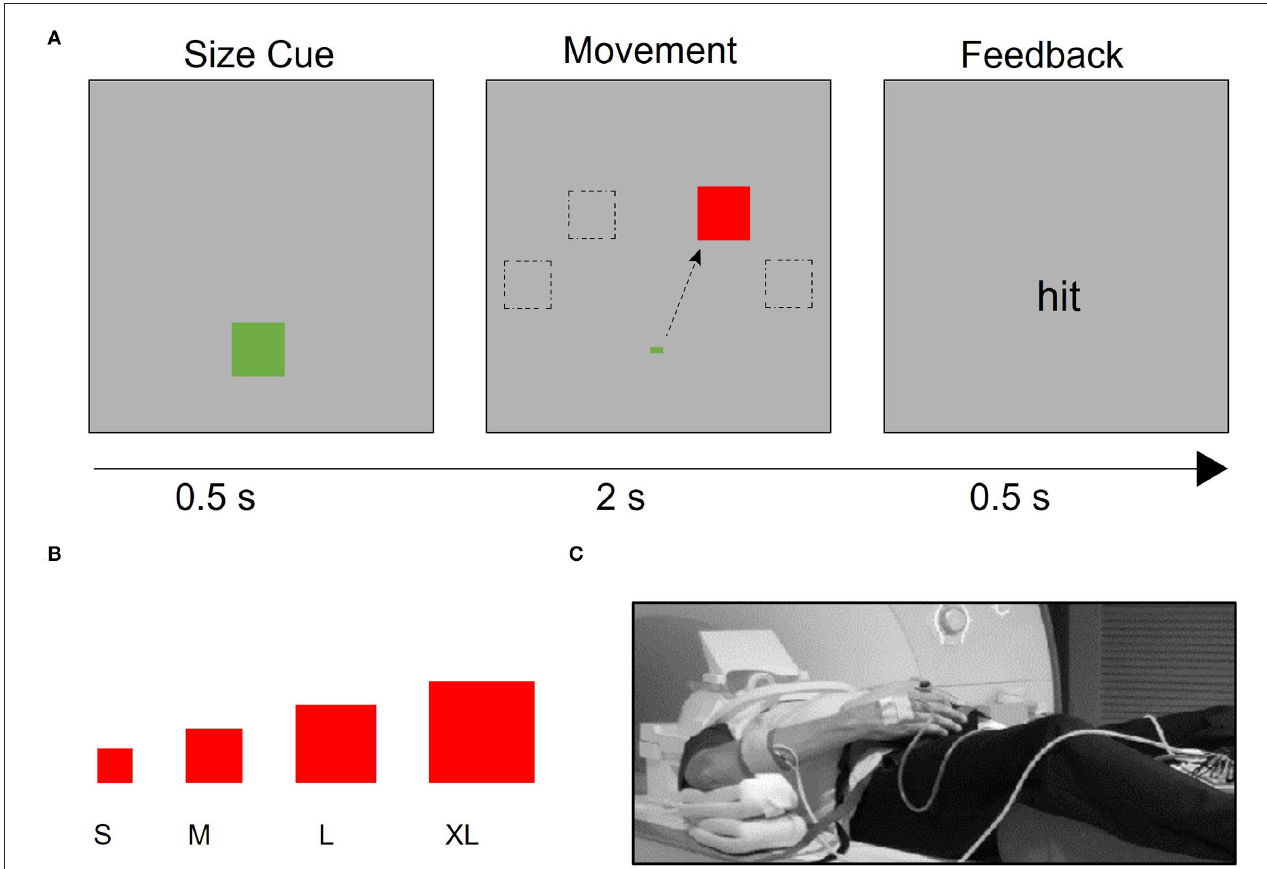
FIGURE 1 | Task design. (A) After a target size cue, the target appears in one of four possible locations ( − 60 ◦ , − 30 ◦ , 30 ◦ , and 60 ◦ relative to the vertical meridian). Participants were instructed to use the joystick to move the cursor to the target as quickly and accurately as possible. If the cursor began at the starting point and was inside the target 2s after the target presentation, participants received “hit” feedback; otherwise, they received “miss” feedback. (B) Four different target sizes were used to vary the demand on precision, (C) Participants used an MRI-compatible joystick to perform the task. The joystick was secured to their body with straps and pads were placed to support the arm and minimize elbow and shoulder movement. EMG electrodes were placed on participants’ right- and left- extensor carpi ulnaris (ECU) muscles, which support the manipulation of the